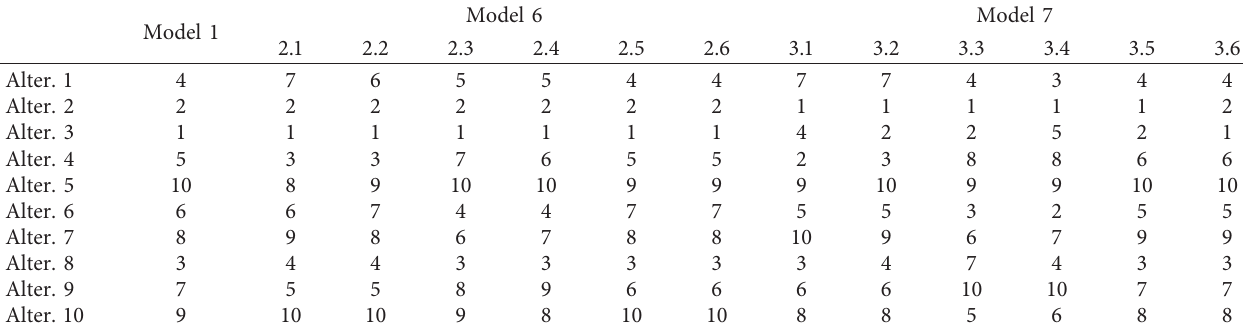
Table 17: Comparison of the ranks of alternatives according to models 1, 6, and 7.